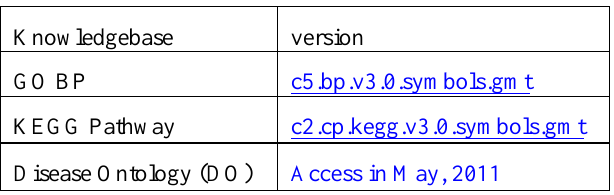
Table 1: knowledgebase and their